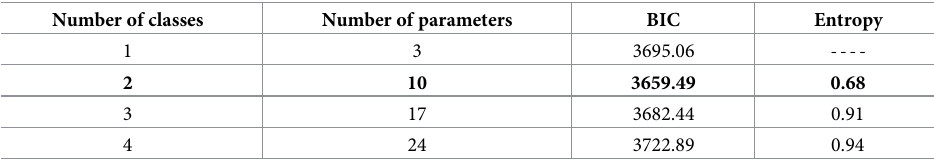
Table 5. Latent class regression (LCR) model summaries for Procedure